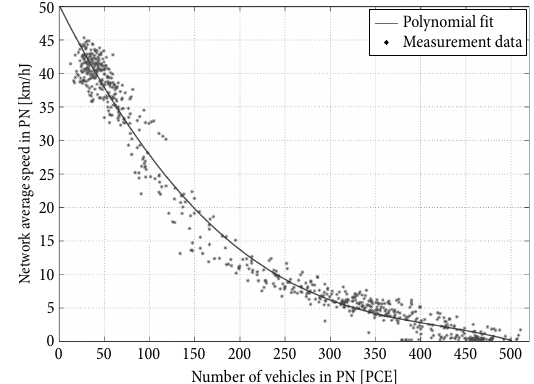
Polynomial fit Measurement data